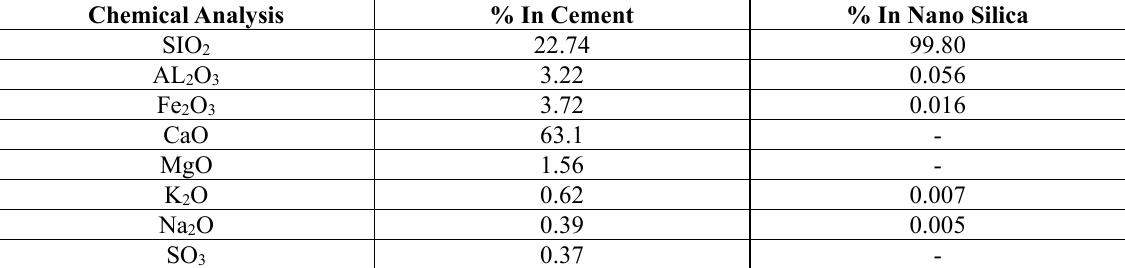
Chemical compositions of Cement and Nano silica. Chemical